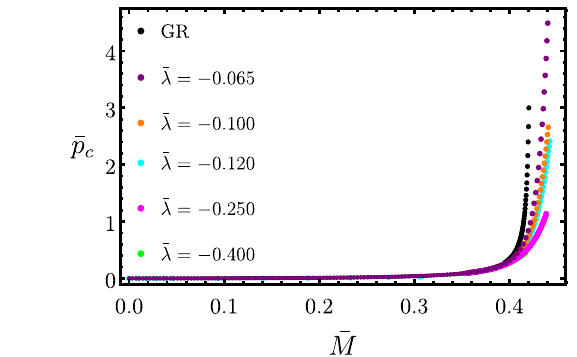
Fig. 6 Central pressure as a function of ¯ M